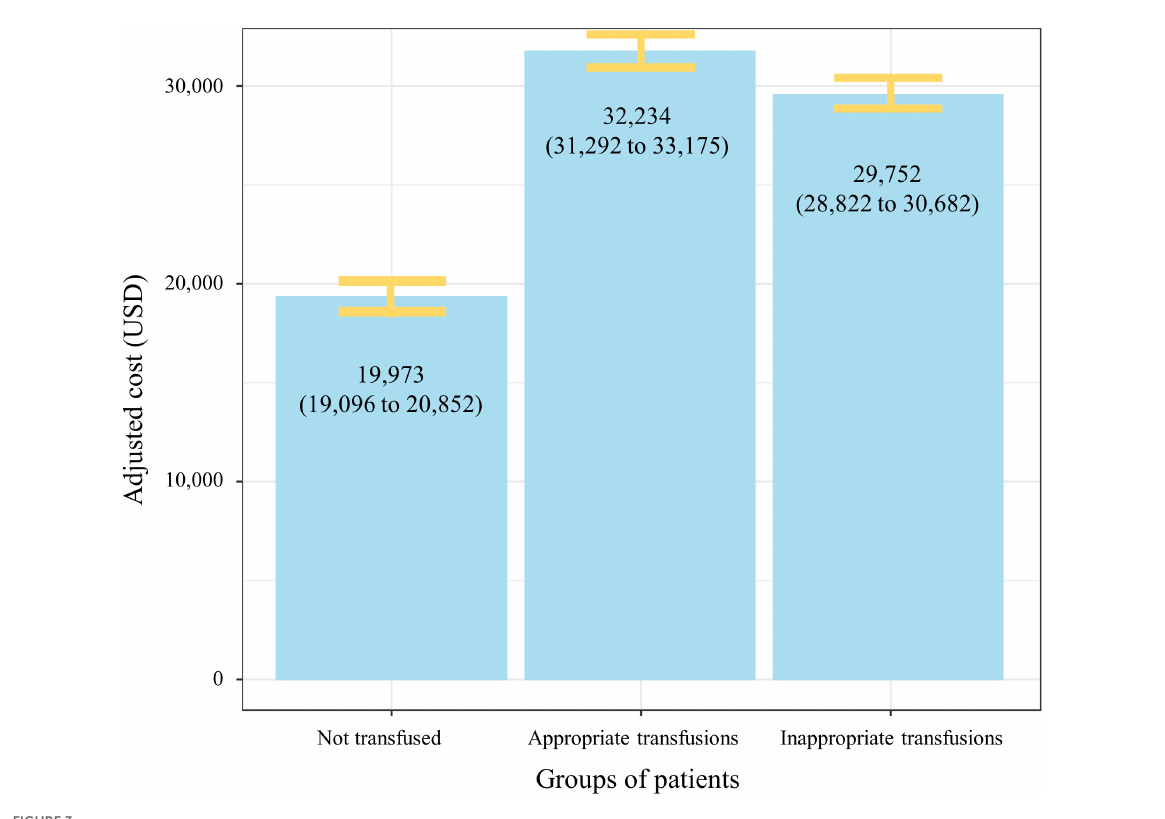
FIGURE3 Adjusted mean hospital costs (95% CI) by red cell transfusion status. The figure demonstrates significant increase in mean hospital costs in patients transfused (appropriately and inappropriately) when compared to patients not transfused red cells. Data are adjusted for age, sex, American Society of Anesthesiologists score, oncology diagnosis, presence of a platelet transfusion, presence of a plasma transfusion, and diagnosis related